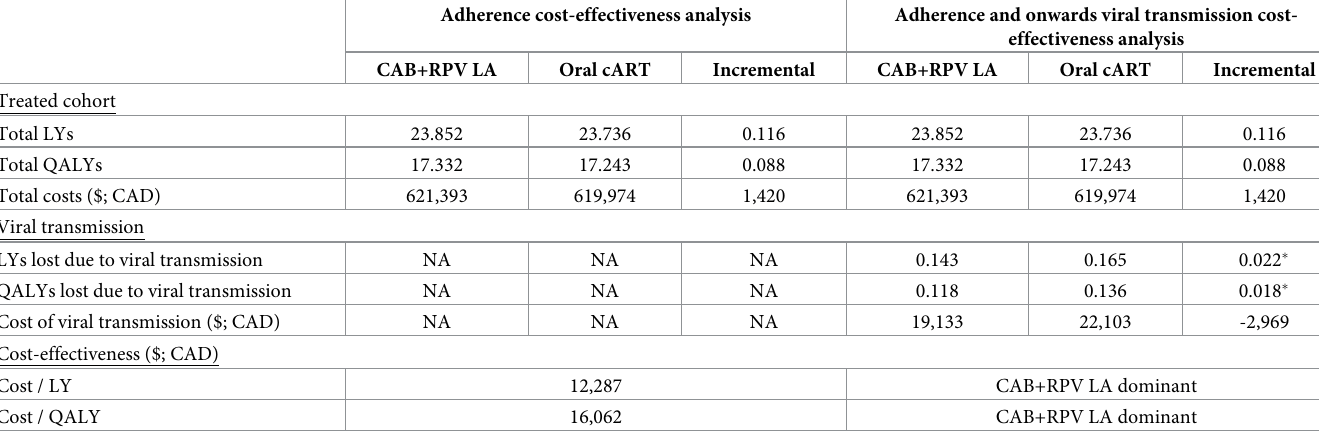
Table 4. Cost-effectiveness results with and without impact of onwards viral transmission (CAB+RPV LA versus oral cART).